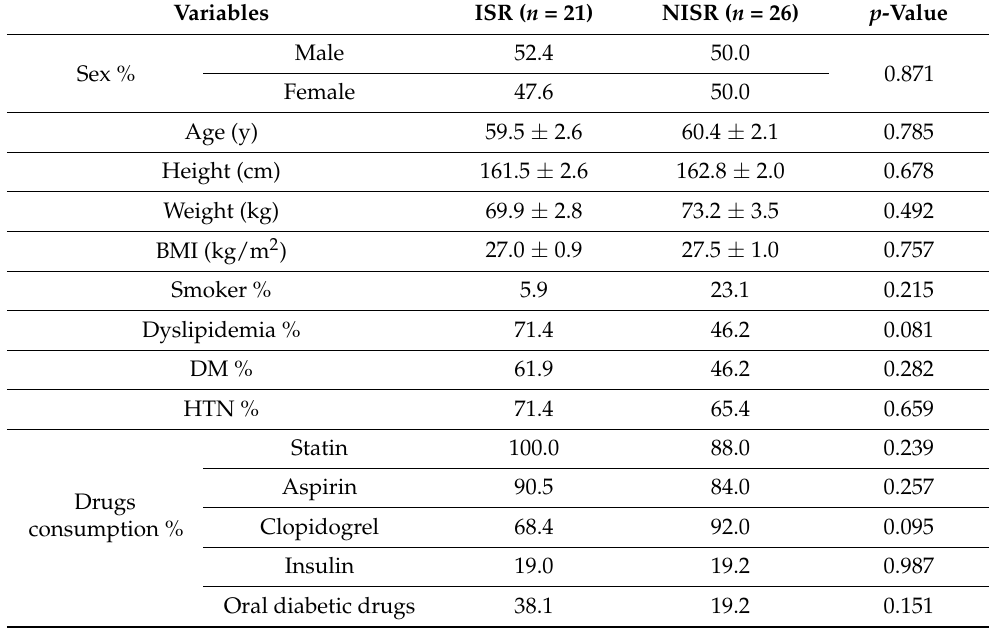
Table 2. Demographic and clinical characteristics of